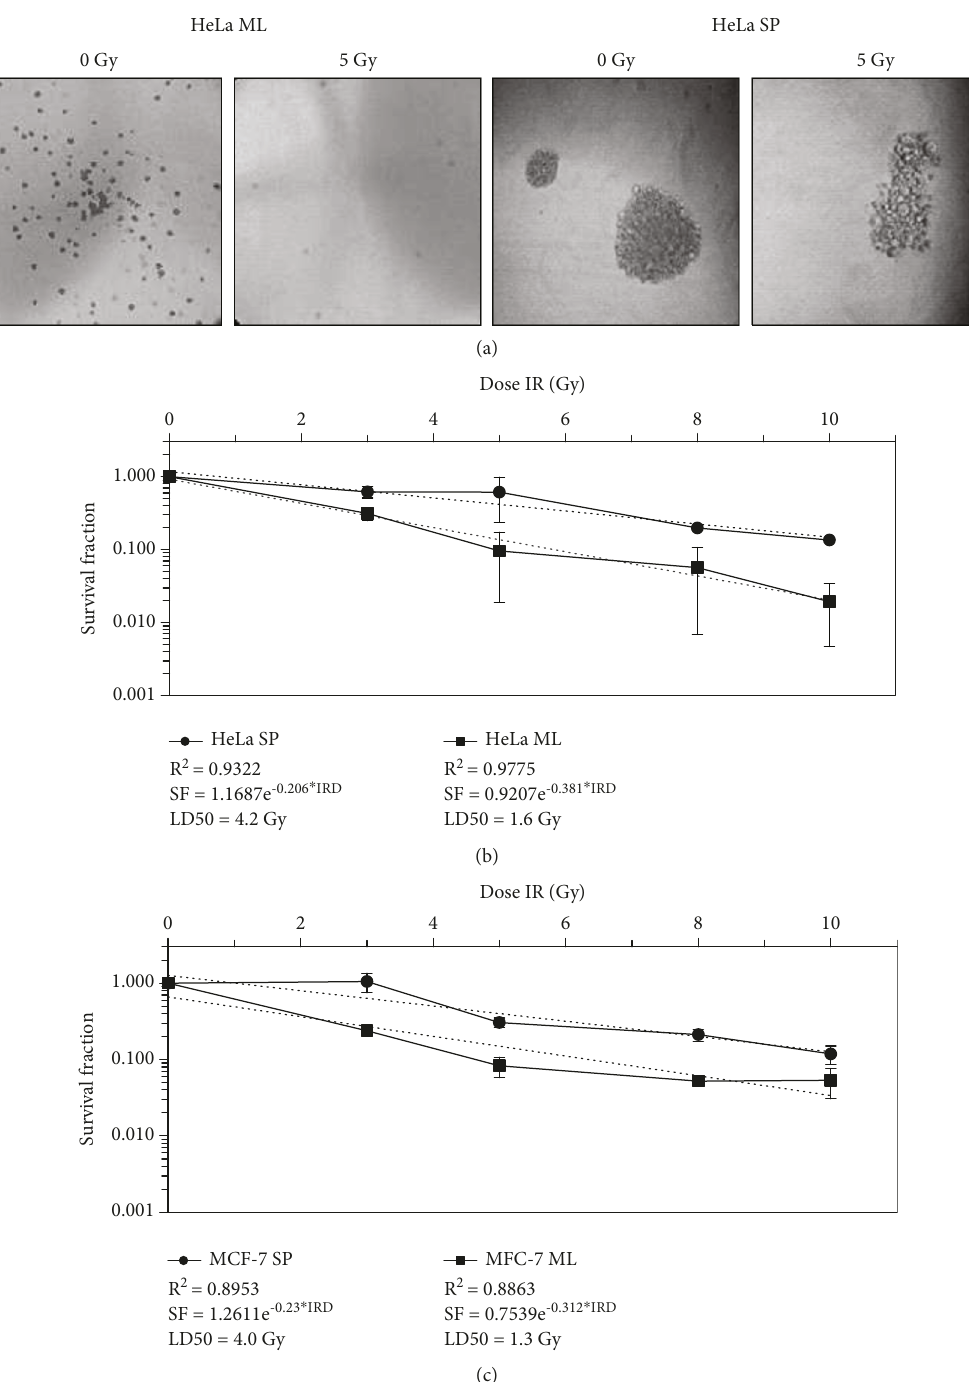
Figure 2: Sphere cultures from HeLa and MCF-7 cells are less sensitive to ionizing radiation. (a) Clonogenic assay indicated that up to a 5Gy IR dose, HeLa ML died while HeLa SP continued to proliferate. Objective 4x and 40x, respectively. (b) Survival data after ionizing radiation doses showed that HeLa SP and (c) MCF7 SP have a higher survival fraction (SF) than HeLa ML and MCF-7 ML cultures. The median lethal dose (LD50) was calculated using an exponential mathematical model; for HeLa ML, this was 1.6 Gy, for HeLa SP, this was 4.2Gy, for MCF-7 ML, this was 1.3Gy, and for MCF-7 SP, this was 4.0Gy. Data shown are represented as mean ± standard error of the mean (SEM) of two independent experiments. IRD: ionizing radiation